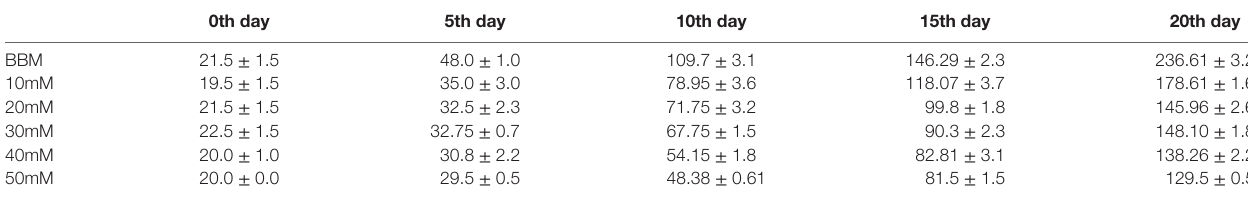
TaBle 2 | Biomass content of S. quadricauda under different salt stress